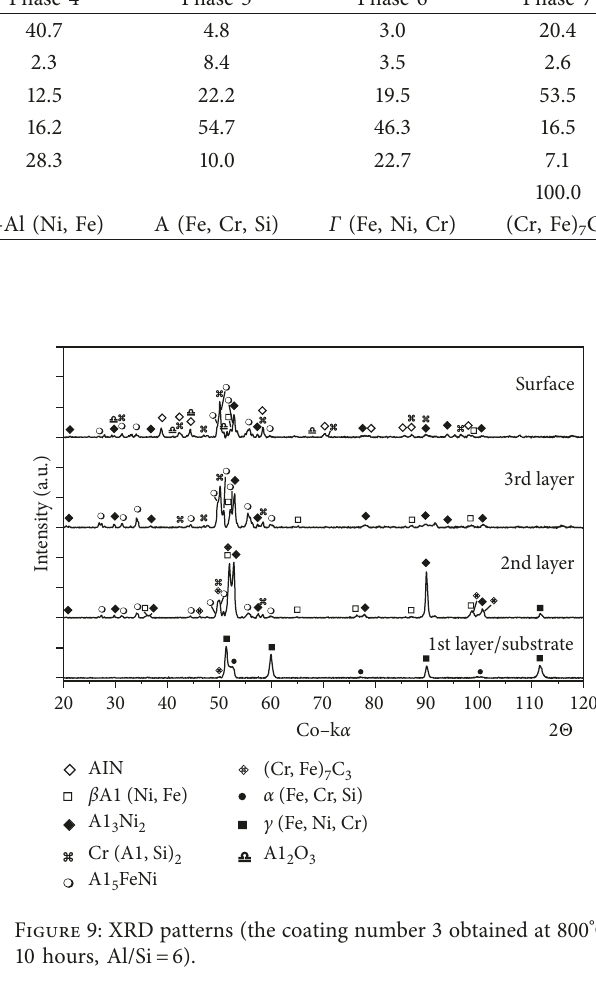
Table 3: Average content of chemical elements in phases according to Figure 7. Element